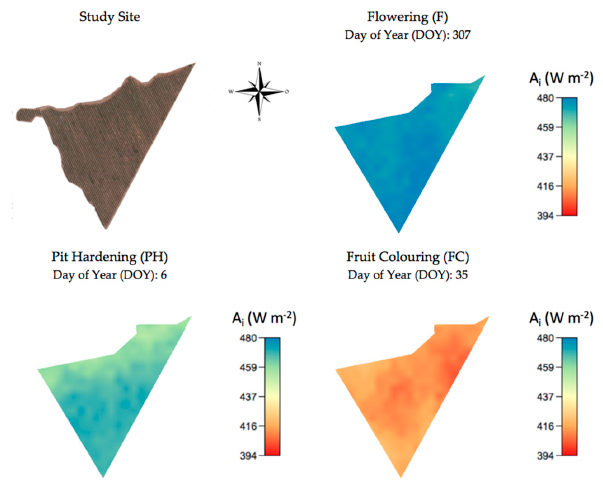
Figure 6. Maps of instantaneous Available energy (A i ) generated from satellite images and ground- based climate data.